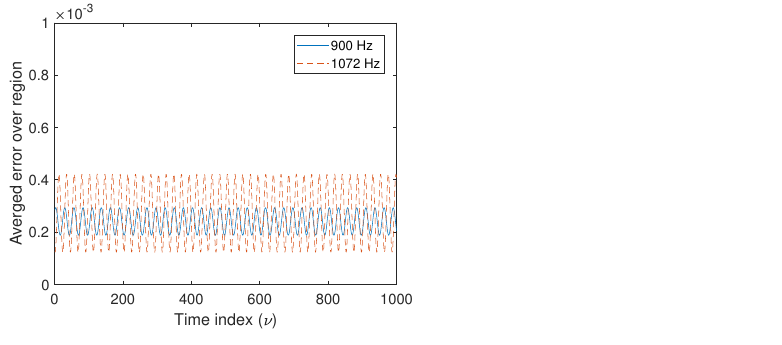
Figure 10. Instantaneous region averaged squared spatial error of the proposed method for sound field reconstruction over space at 900 Hz and 1072 Hz (Bessel